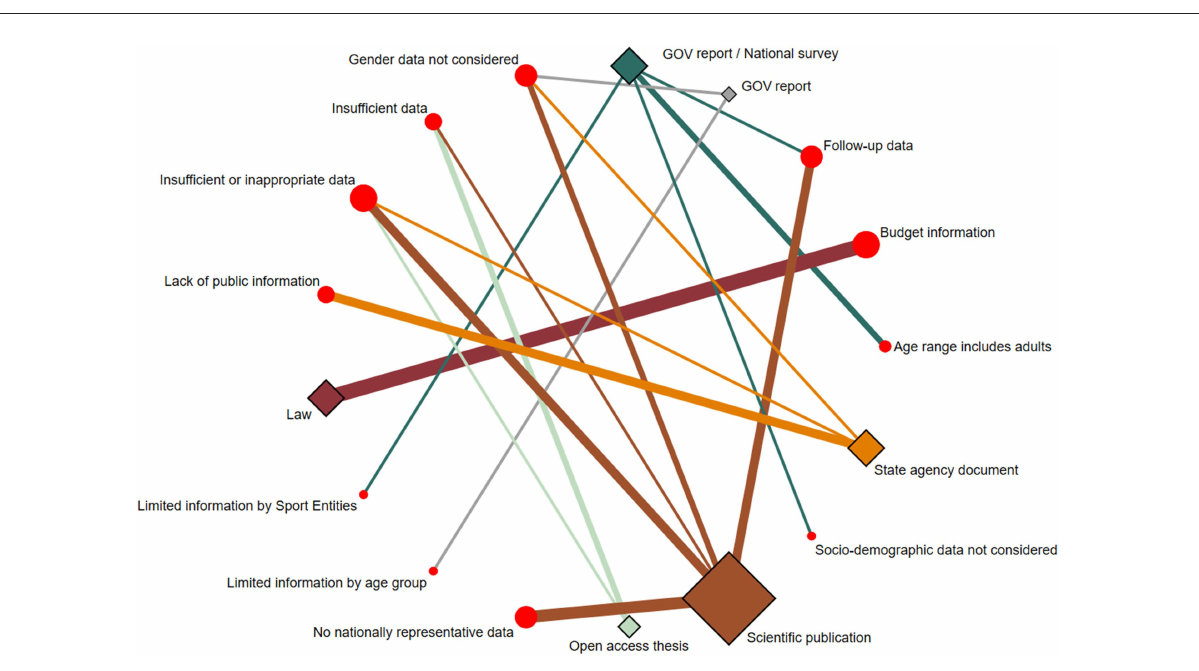
FIGURE6 Network geometry plots of available comparisons between the type of evidence and their weaknesses. The size of the circular nodes (evidence weaknesses) was relative to the number of papers analyzing these components. The size of the diamond nodes (type of evidence) was relative to the number of available data on evidence weaknesses analyzing these components. The width of the solid line connecting the nodes was relative to the number of papers analyzing the evidence weaknesses (circular nodes) according to the type of evidence (diamond nodes). GOV,